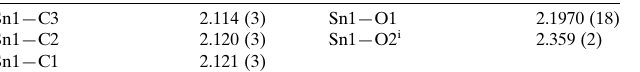
Selected bond lengths (A˚